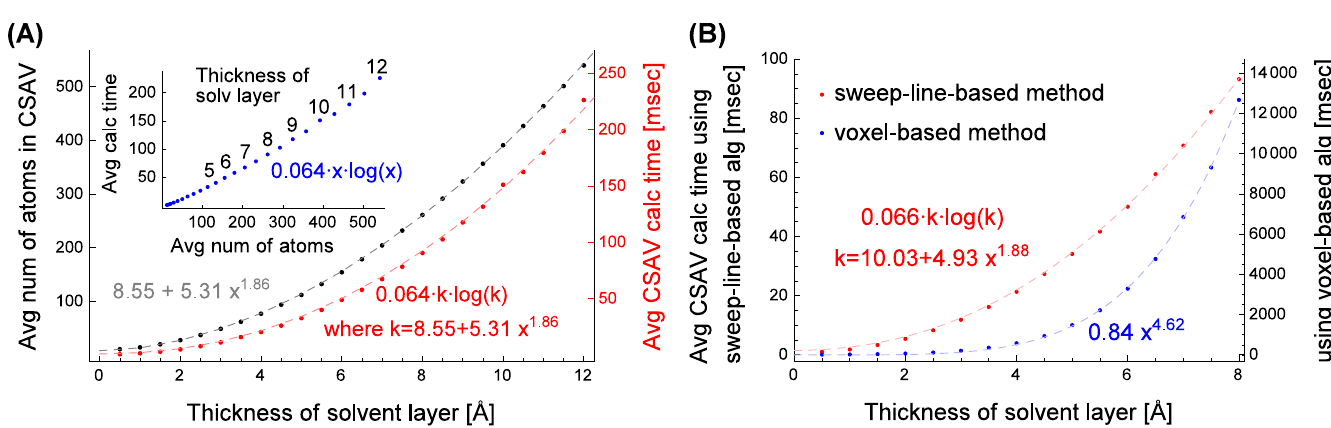
Fig 8. The relationship between the thickness of the solvent layer and the computational cost of sweep-line-based and voxel-based methods. (A) The relationship between the thickness of the solvent layer, the number of atoms involved in the CSAV calculation, and the CSAV computation time of the sweep-line-based method. (B) The comparison of the computation time of the sweep-line-based method and that of the voxel-based method when the thickness of the solvent layer increases.